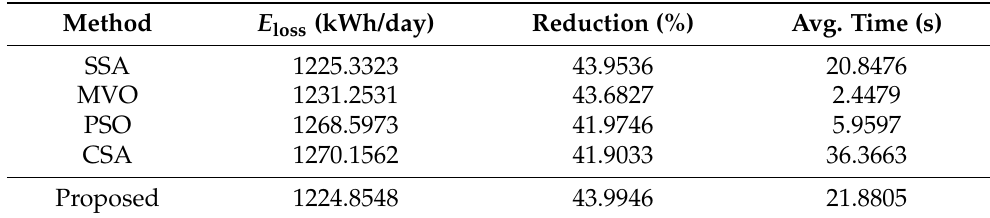
Table 4. Comparison of the proposed recursive convex approximation with combinatorial optimiza- tion